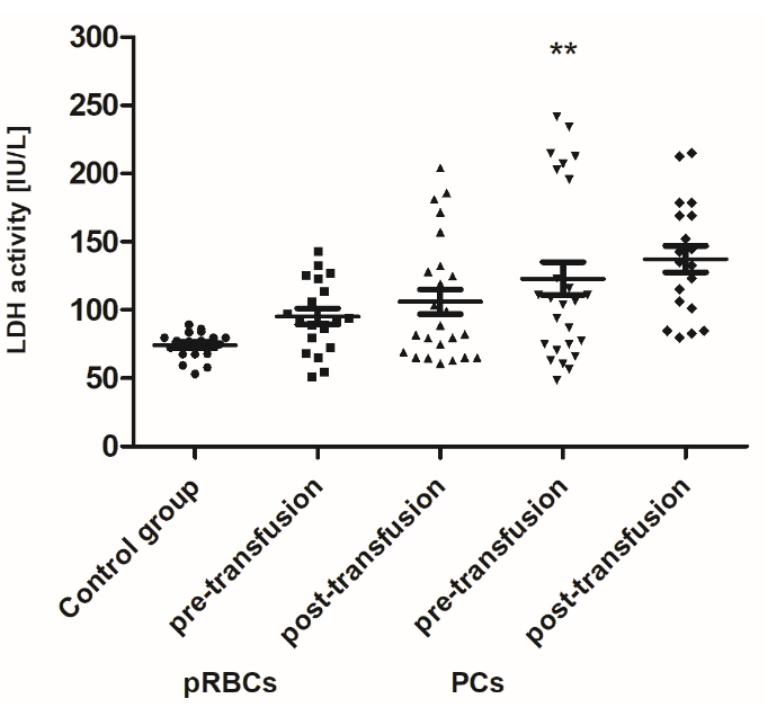
Figure 9. The activity of extracellular LDH in healthy volunteers (control group) and AML patients before and after transfusion of the blood component. Scatter plots show all of the data values obtained. Data are presented as mean ± SE. ** p < 0.01 compared to the control group; statistically significant according to the Tukey test. pRBCs—packed red blood cells; PCs—platelet concentrates.